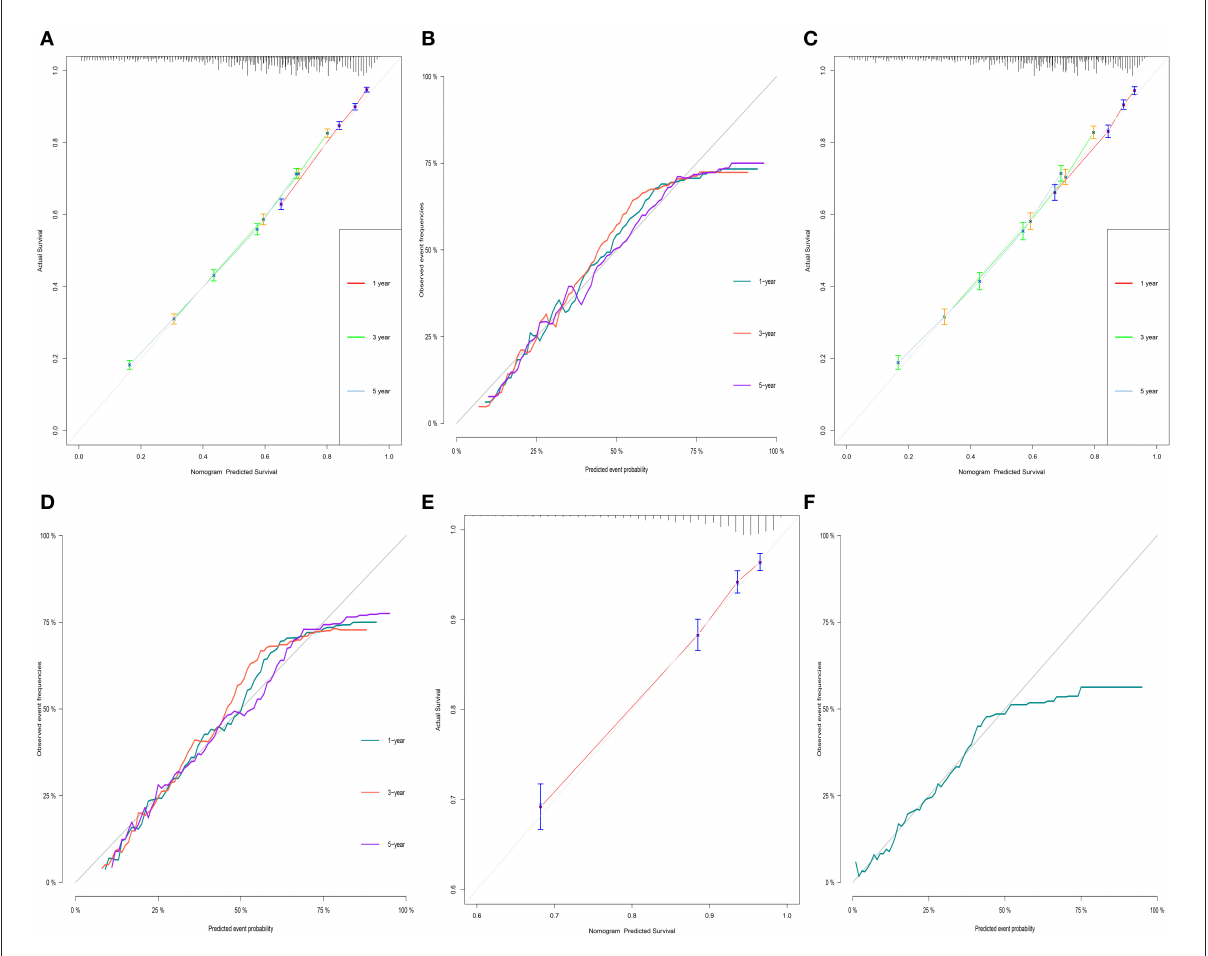
FIGURE4 Calibration curves of OS and CSS in training group (A,B) , validation group (C,D) and external validation group (E,F) for validating nomogram models.